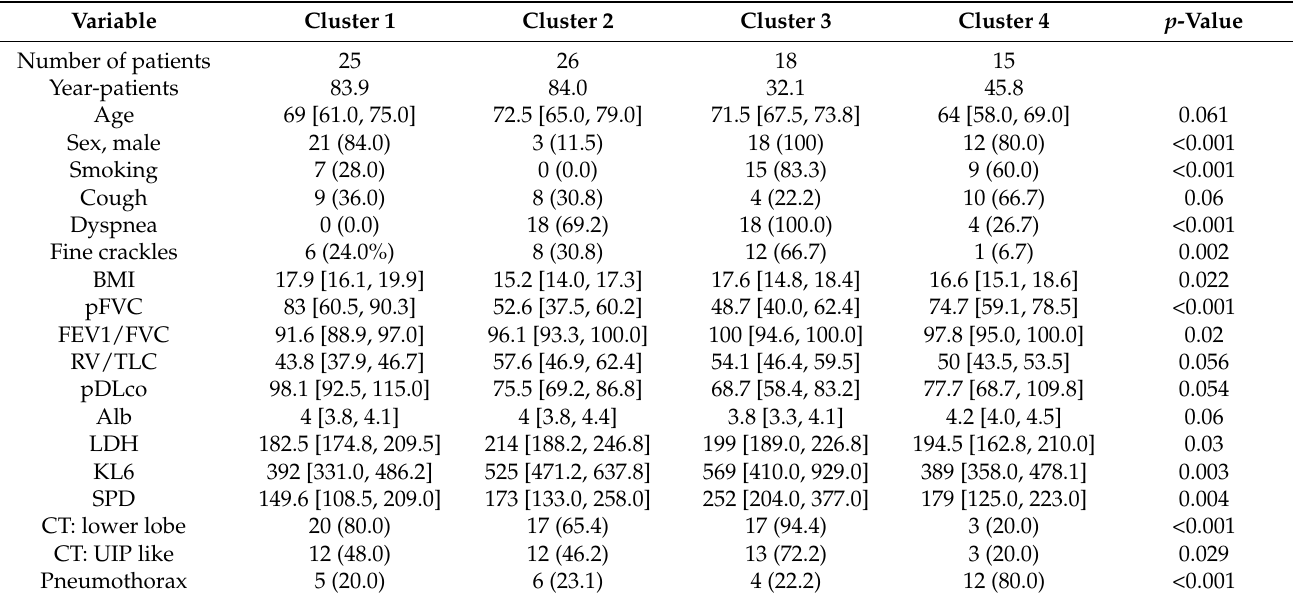
Table 3. Differences in clinical characteristics between the four